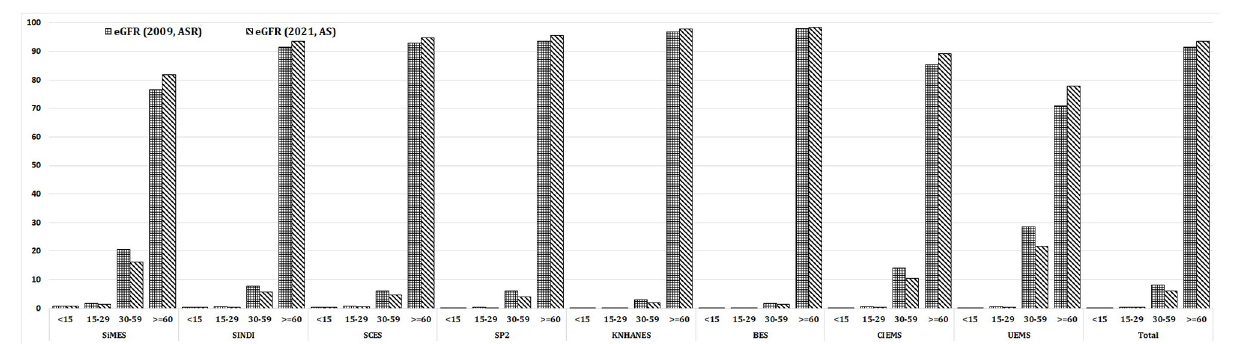
to eGFRcr-ASR, eGFRcr-AS had a negative effect on G3-G5 prevalence [ − 1.9% ( − 2.2% to − 1.5%)] while eGFRcys-AS has a positive effect [4.2% (3.5% to 4.9%)]. Supplementary Table